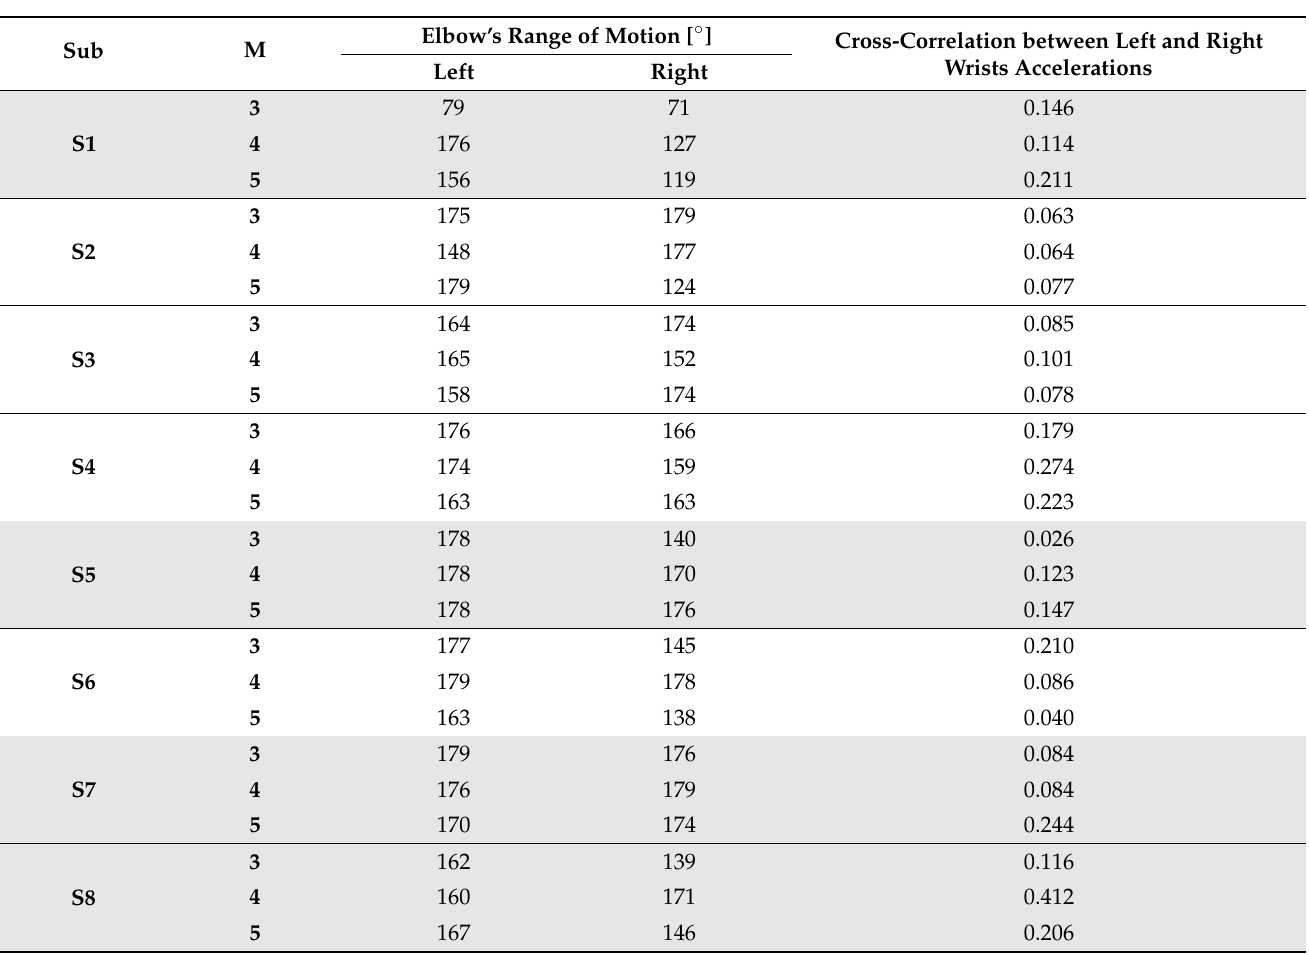
Table A3. Relevant values of parameters described in Figures 5 and 6 for each infant at each timepoint (3, 4, and 5 months). Subjects not